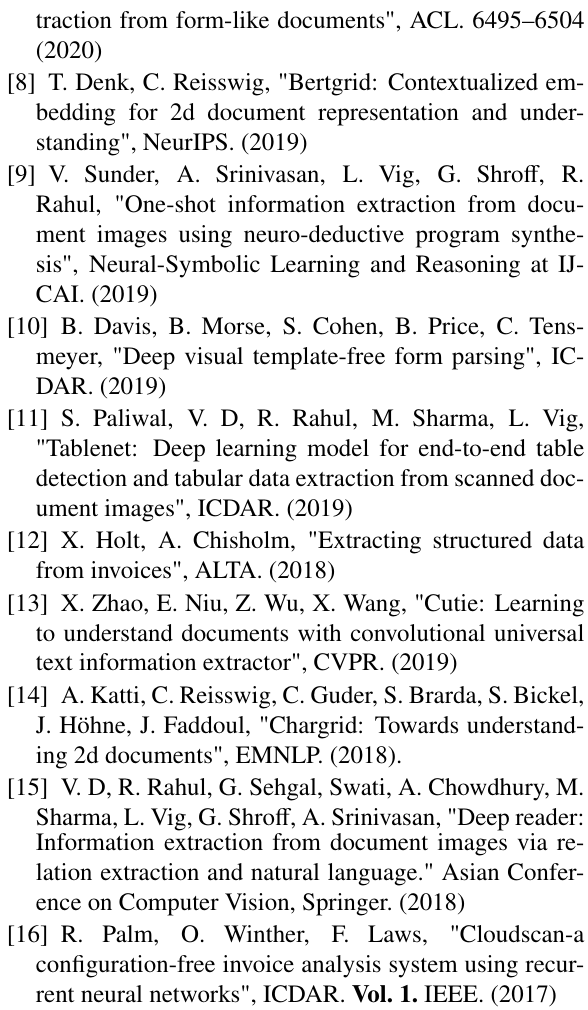
"Tablenet: Deep learning model for end-to-end table detection and tabular data extraction from scanned doc- ument images", ICDAR.